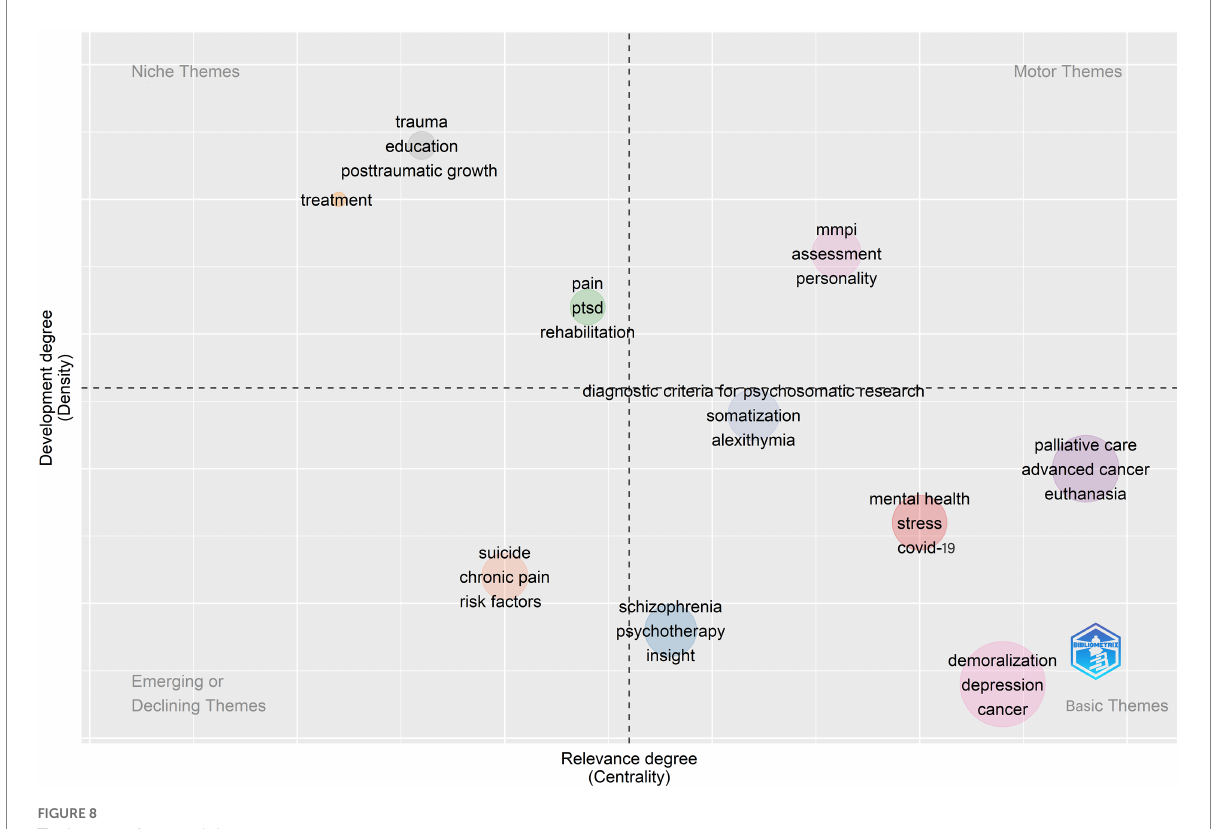
FIGURE 8 Topic map of research